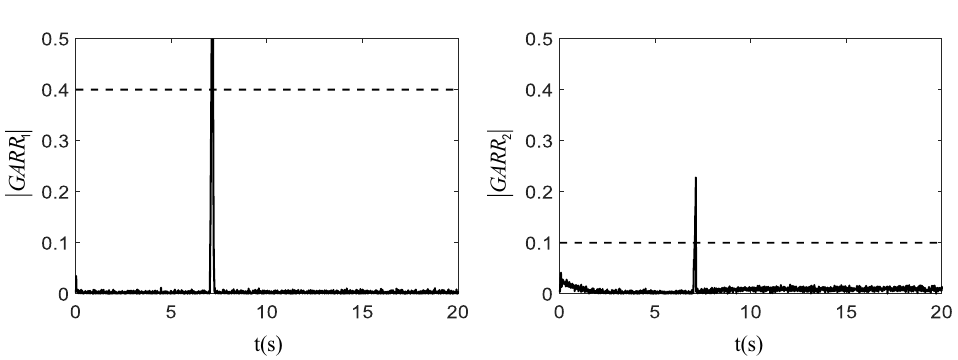
Figure 3. N a : ( a ) Desired N a . ( b ) Actual N a .